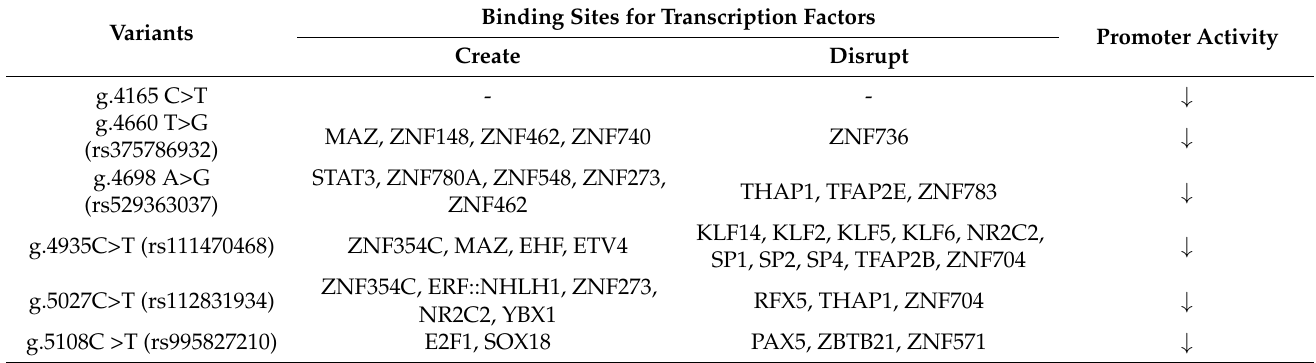
Table 3. Effects of the promoter region variants of the CITED2 gene on TFBS predicted by JAS- PAR database.